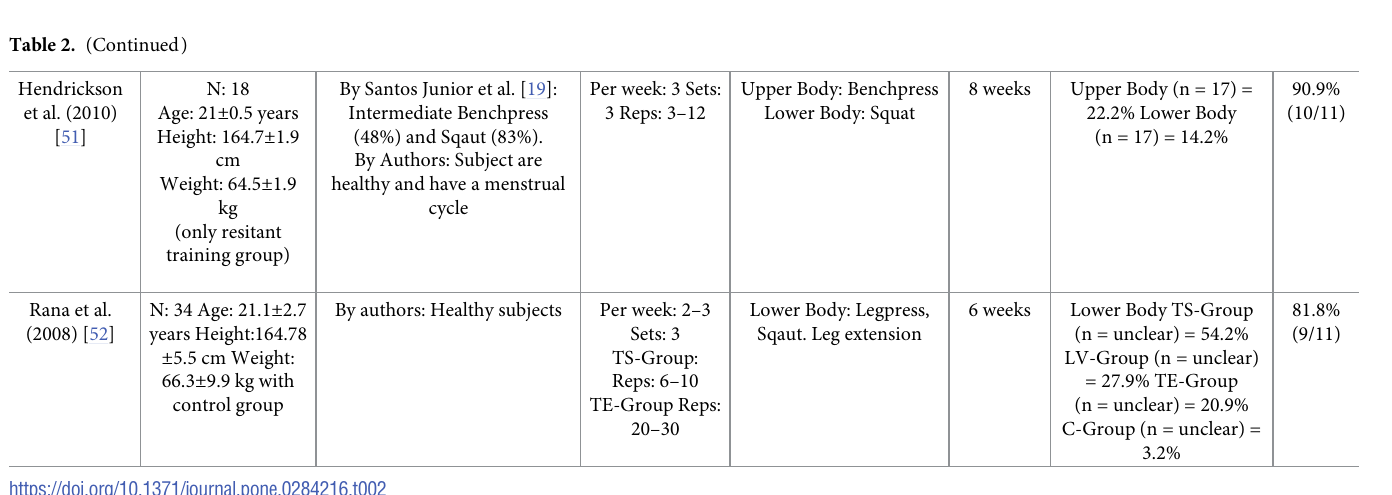
7.2% and in the lower body by 5.2% per week. The quality of every study is also listed in Table 2 (last column).